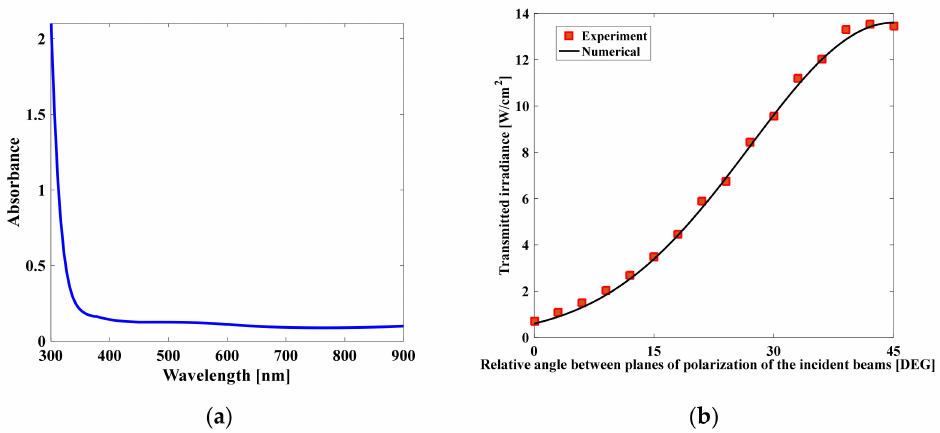
Figure 5. ( a ) UV-vis absorbance of the NiO thin films. ( b ) Nanosecond transmitted probe irradiance as a function of the relative angle of polarization between the incident beams at a 532 nm in the NiO thin